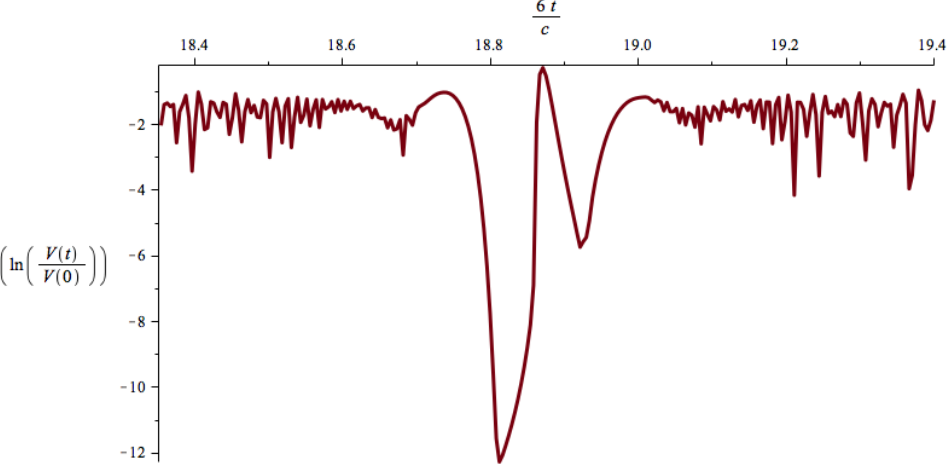
Figure 2 . Same parameters as in (cid:12)gure 1 but now over larger time range.